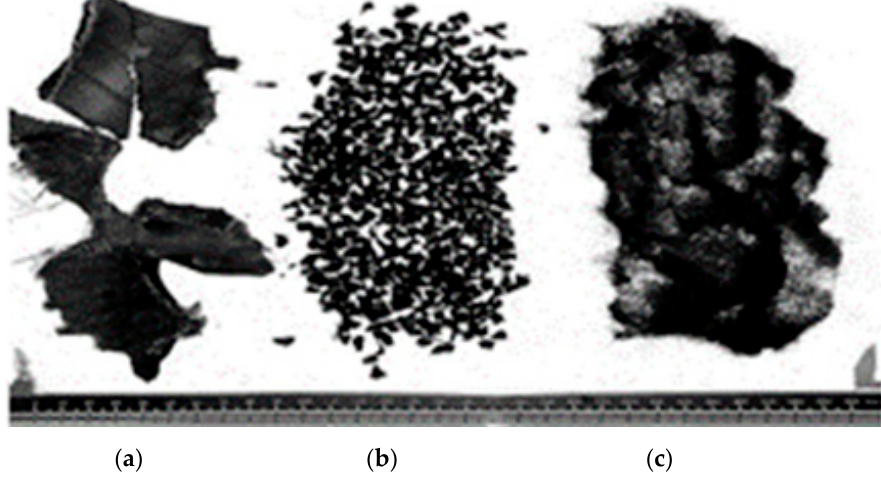
Figure 1. Waste tyre rubber classifications: ( a ) Chipped, ( b ) crumb, ( c ) ground rubber [21].